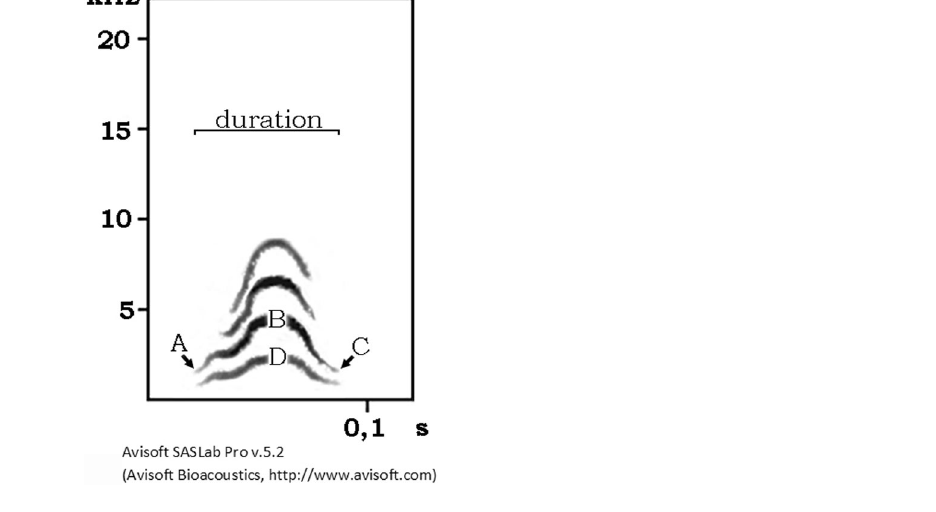
Figure 5. A sonogram of Call-1 and acoustic measures used to test whether Call-1 is individually distinctive. A: frequency of the beginning of the dominant frequency, B: frequency of the mid-part of the dominant frequency, C: frequency of the end of the dominant frequency, D: frequency of the mid-part of the fundamental frequency.